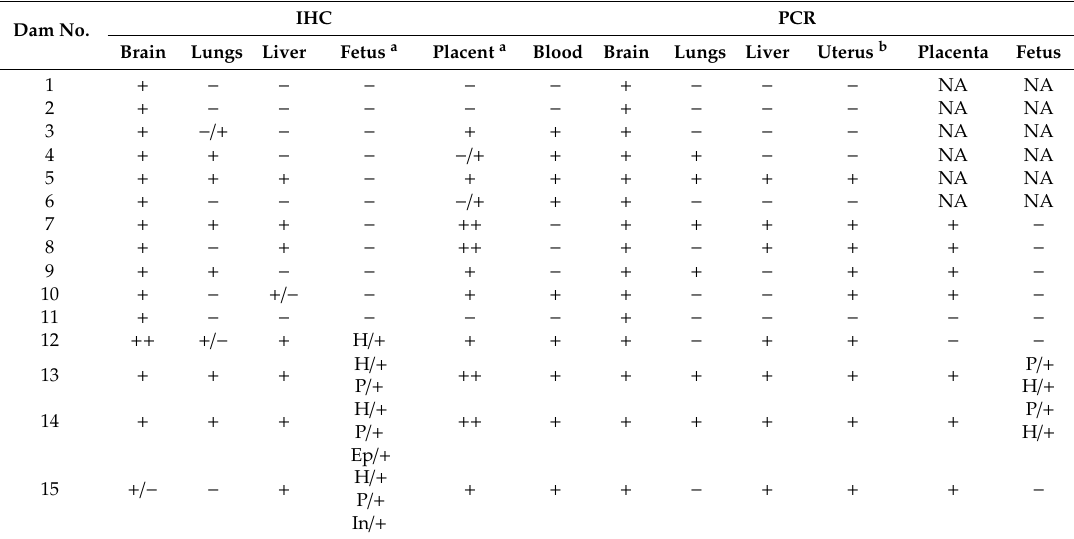
Table 3. Summary of the immunohistochemical detection of EHV-9 antigen and PCR amplification of EHV-9 ORF30 gene from di ff erent organs, fetuses, placentas, and uterine walls of pregnant hamster dams intranasally-inoculated with